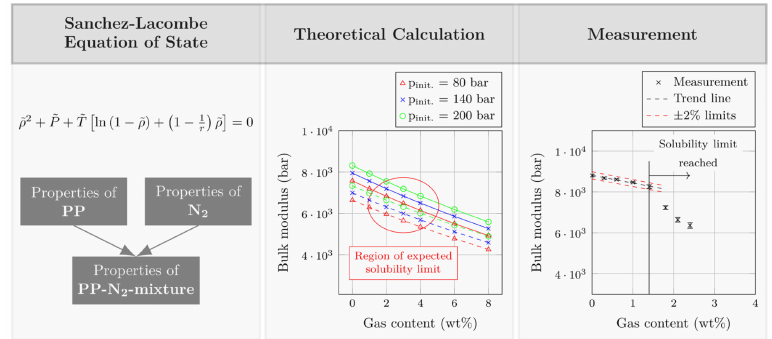
Figure 2. Workflow for identifying the compression behavior of polymer–gas mixtures with excessive gas